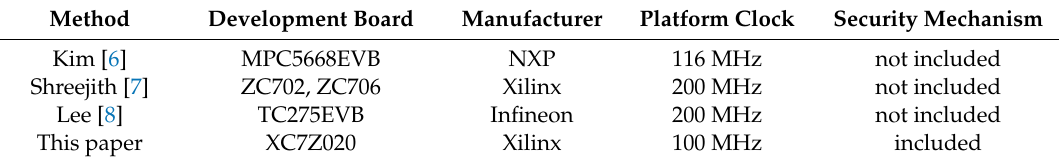
Table 1. Comparisons of platforms and their security